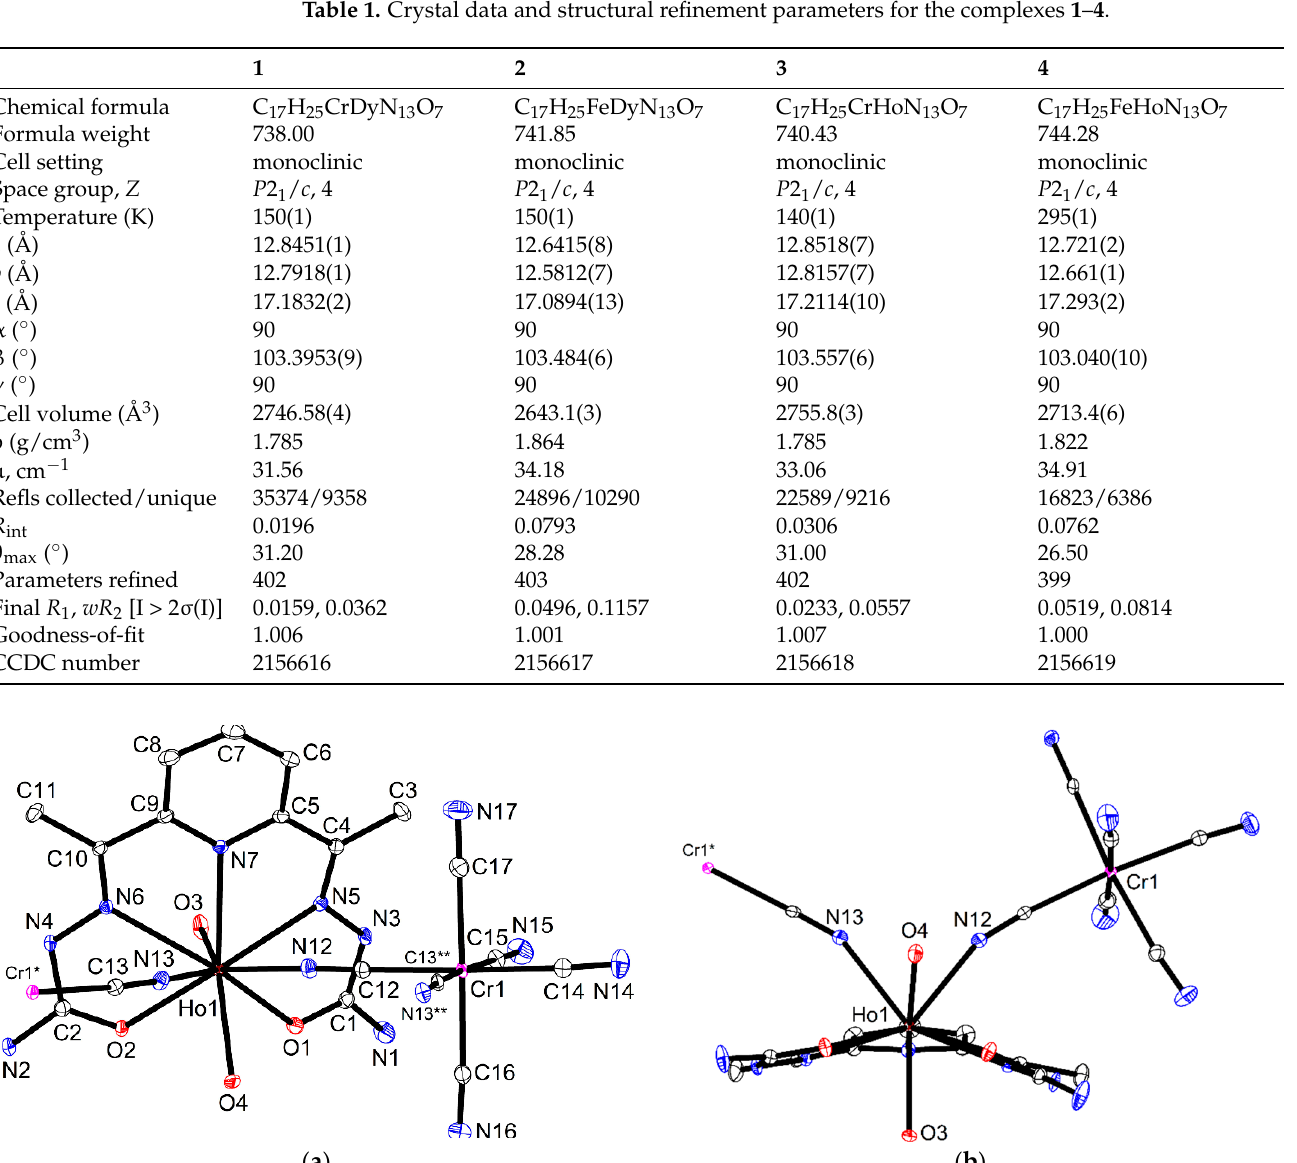
( b ) Figure 3. ( a ) Infinite square-wave chain in 3 . Chain-defining bonds are shown by black solid lines, hydrogen bonds—by red dashed lines. ( b ) Fragments of two adjacent chains with interchain hy- drogen bonding (see Tables S2–S5 for hydrogen bond geometry). Formation of the square-wave type of chain is supported by strong hydrogen in- trachain bonding shown by red dashed lines in Figure 3a. Details of H-bond geometry is given in Tables S2–S5 and discussed further on the example of structure 3 (HoCr). The shortest hydrogen bond between the adjacent non-connected [Ho(H 2 dapsc)(H 2 O) 2 ] and [Cr(CN) 6 ] units in the chain, O(3)-H(3wa)…N(14), fixes the square-wave shape. The H…N distance in this bond is 1.93 Å, the distance between Ho and Cr ions linked by this hydrogen bond is 7.2368(5) Å. Second aqua ligand is hydrogen bonded to N atoms of